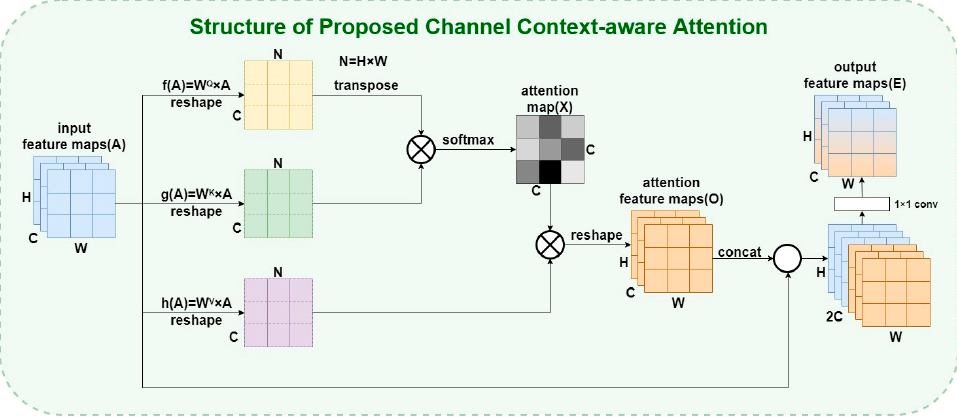
Figure 5. The structure design of the proposed CCA module.